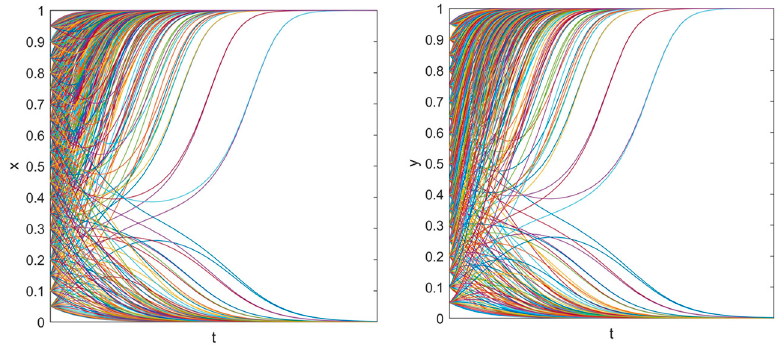
Figure 4. Strategies’ evolutions of the grid company and user over time in Case 1.